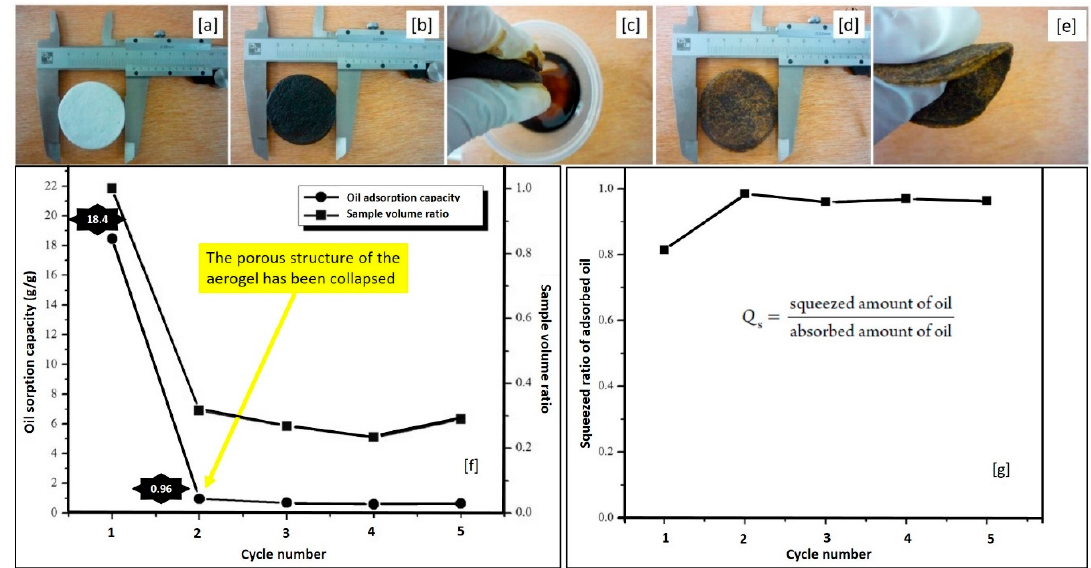
Figure 8. The squeezing process. ( a ) Cellulose aerogel from paper waste, ( b ) cellulose aerogel after first sorption cycle, ( c ) mechanical squeezing, ( d ) cellulose aerogel sample after squeezing, ( e ) good flexibility of the material, ( f ) effect of cycles on oil sorption capacity and sample volume of the aerogel, ( g ) effect of cycles on squeezed ratio of absorbed oil (adapted and modified from [95] with permission from ACS).